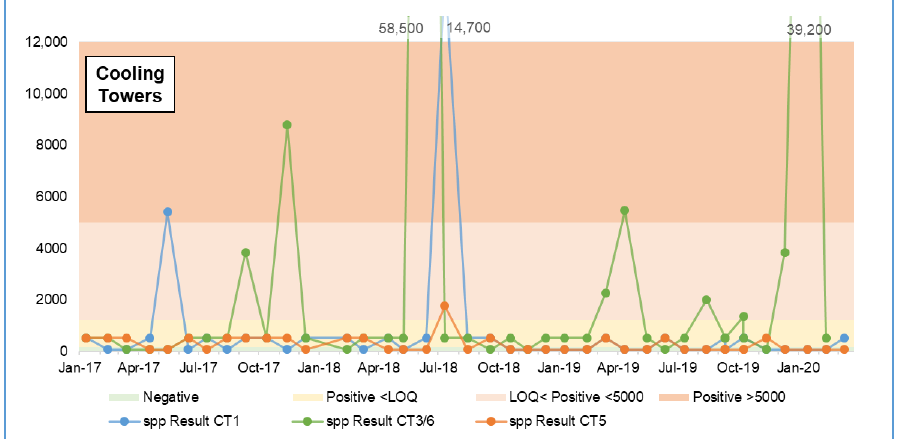
Figure 6. Legionella spp. qPCR data for the cooling towers over the three-year period.